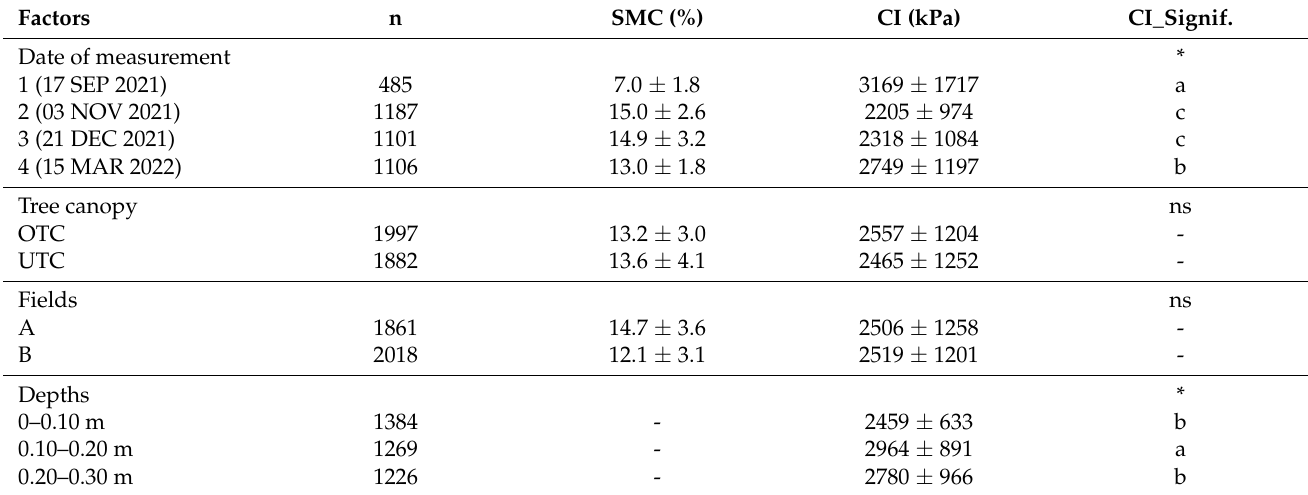
Table 3. Descriptive statistics (mean ± standard deviation) of soil moisture content (SMC) and Cone Index (CI) between September 2021 and March 2022, and inferential analysis of CI.